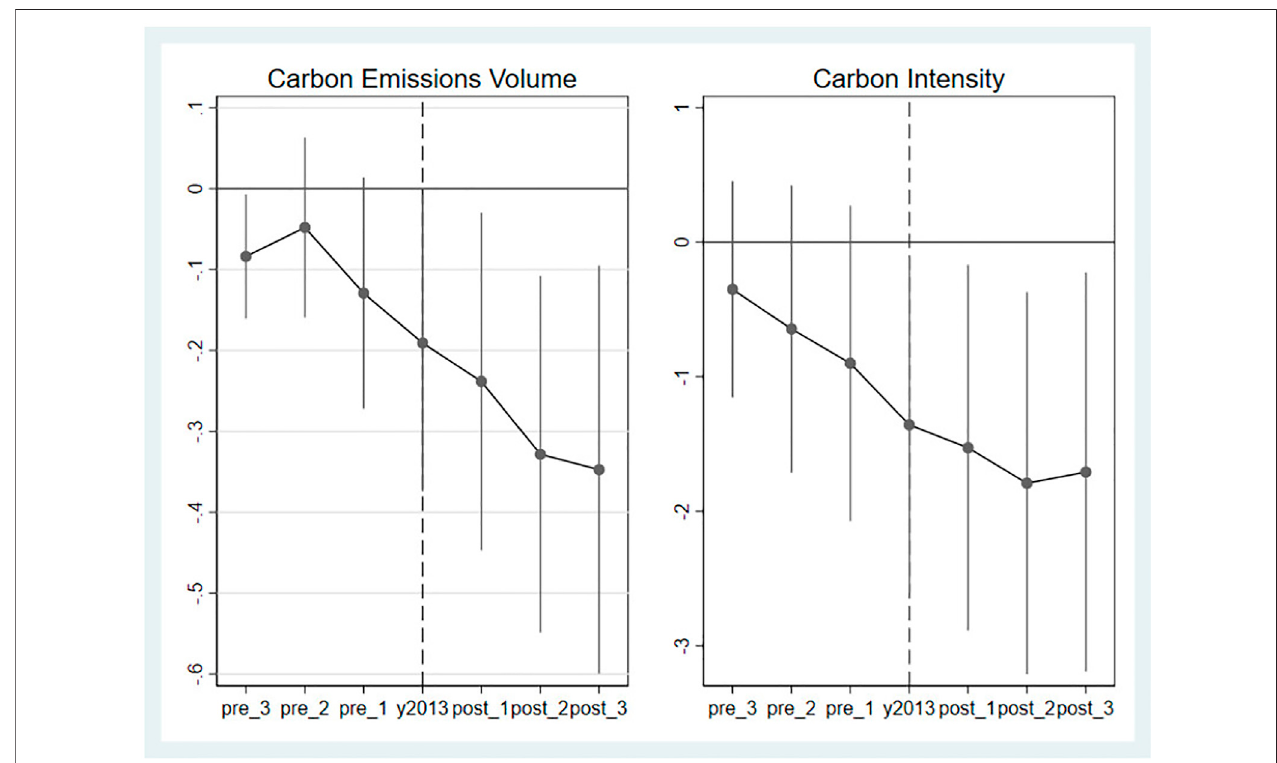
FIGURE 5 | The Impact of Carbon Trading on Regional Industrial Carbon Emissions: Dynamic Effect. Note: The vertical lines in the graphs represent the 95% con fi dence interval of the estimated regression coef fi cient.